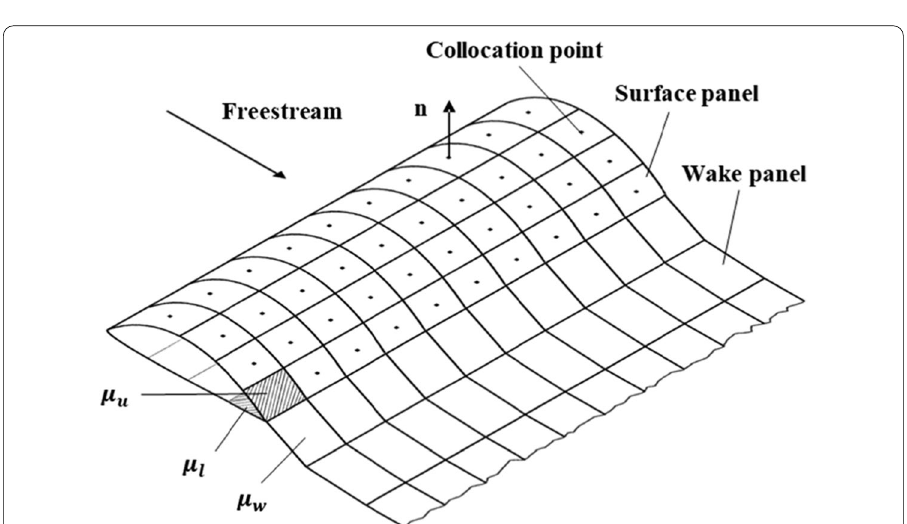
Fig. 2 Surface and wake panels arrangements on